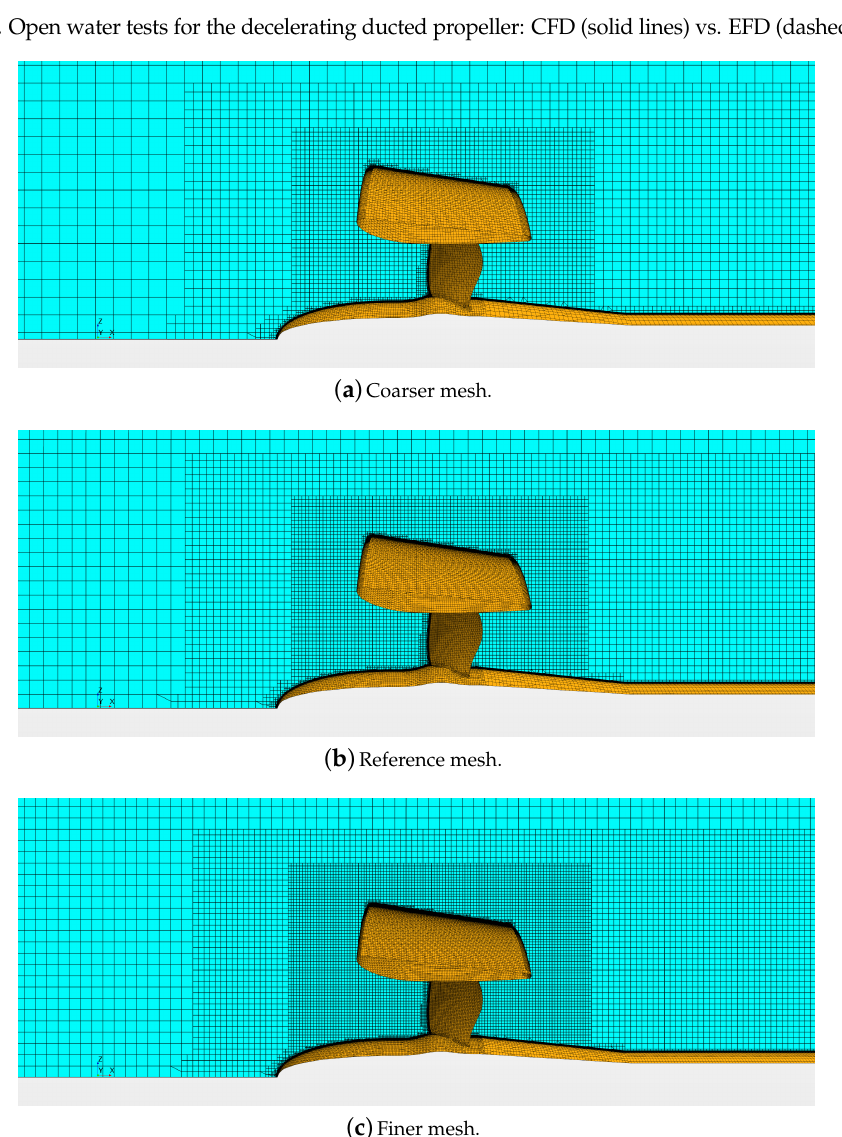
Figure 5. Sketches of the adopted meshes for the sensitivity